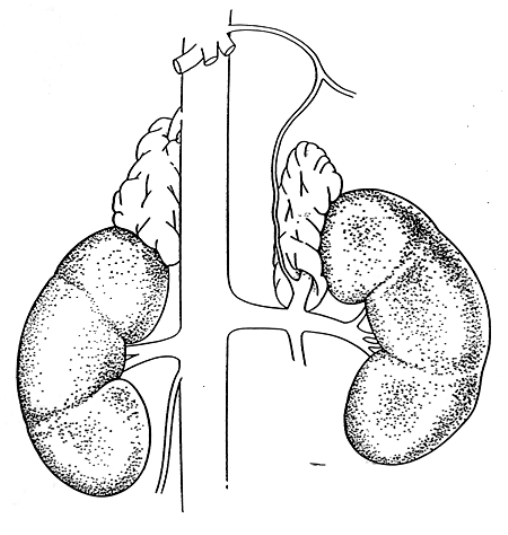
FIGURE 2. Venous drainage from both adrenals showing the presence of both the left adrenal vein and the phrenic branch. Also showing the short, stubby posterior arising right adrenal